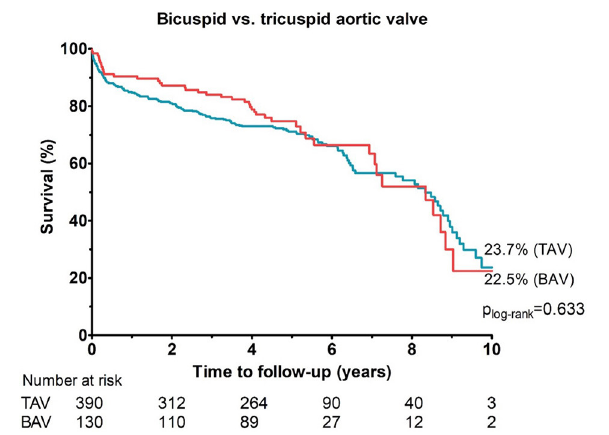
TABLE 2 | Procedural characteristics and in-hospital outcomes.